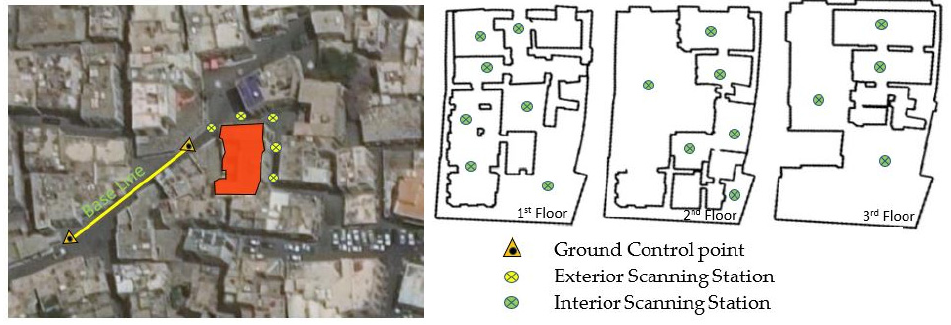
Figure 6. General scanning work plan.